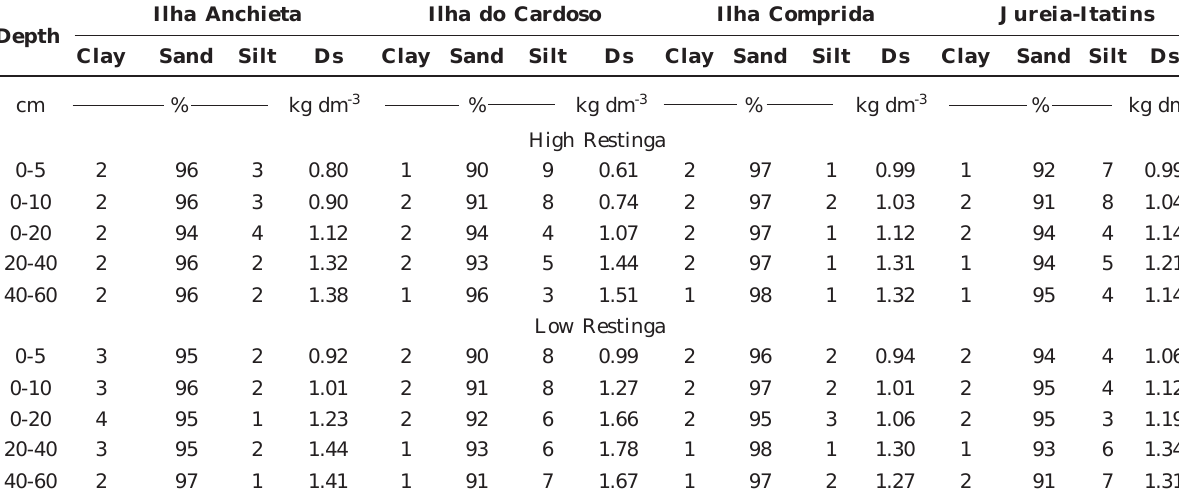
Table 3. Results of the physical analyses of soil under restinga forest in advanced (high) and intermediate (low) stages of regeneration at four locations